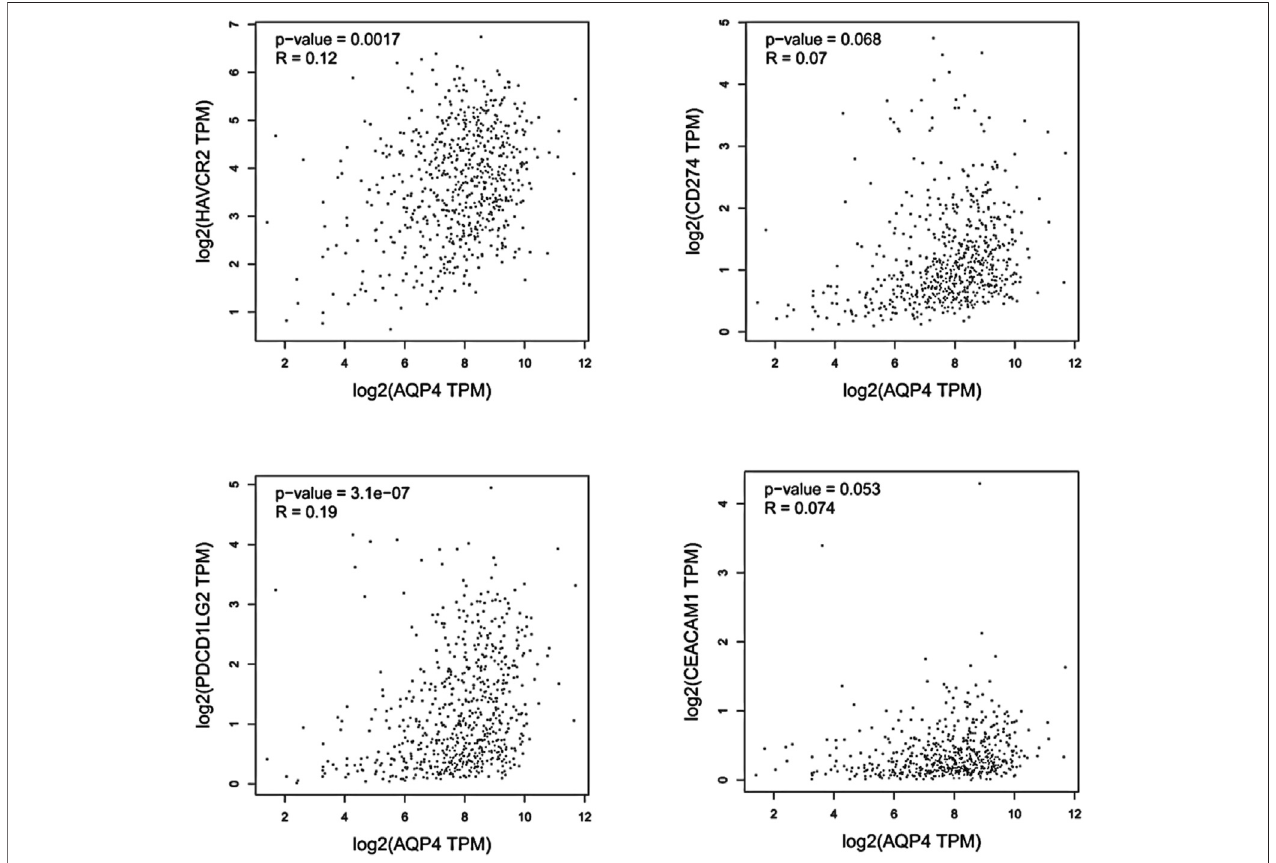
FIGURE3| UsingGEPIA,theexpressioncorrelationbetweenAQP4andAQP4-correlatedimmunecheckpointswereanalyzed,includingTIM-3(HAVCR2),PD-L1 (CD274), PD-L2 (PDCD1LG2), and CEACAM1, using GBM and LGG samples.